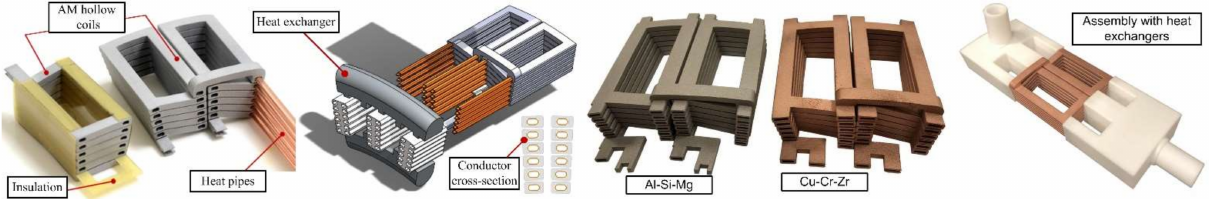
Figure 12. AM coils of hollow conductors integrated with cooling channels for direct heat ex- change